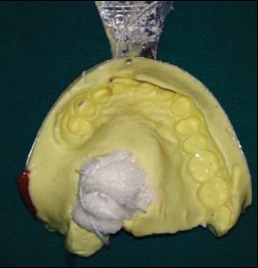
Primary impression.